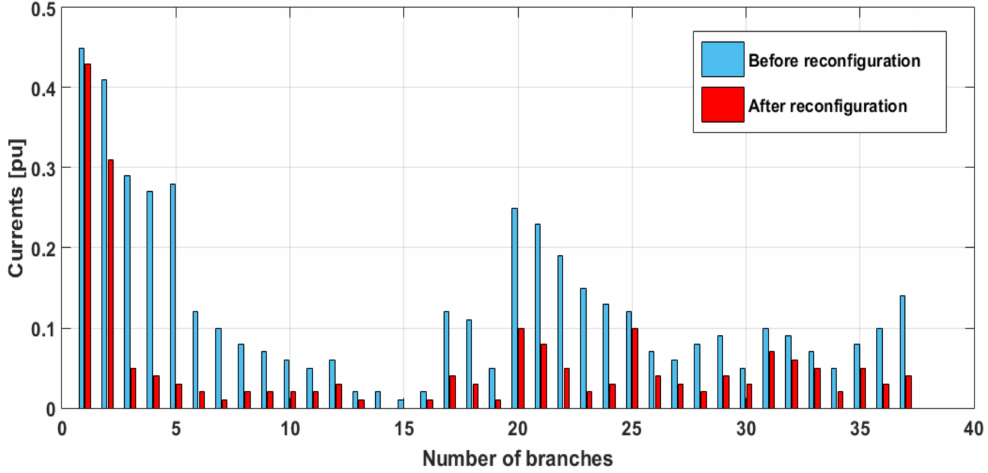
Figure 8. Currents profiles for the minimization of the ENS criterion (before and after